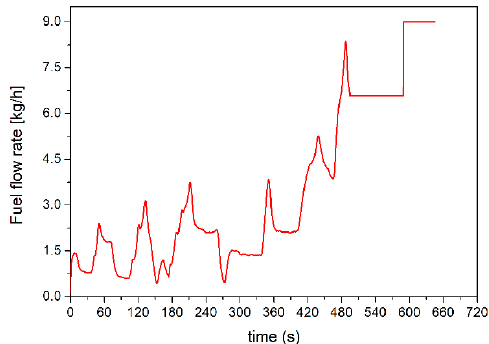
Figure 22. Fuel flow rate variation for prolonged high load operation.